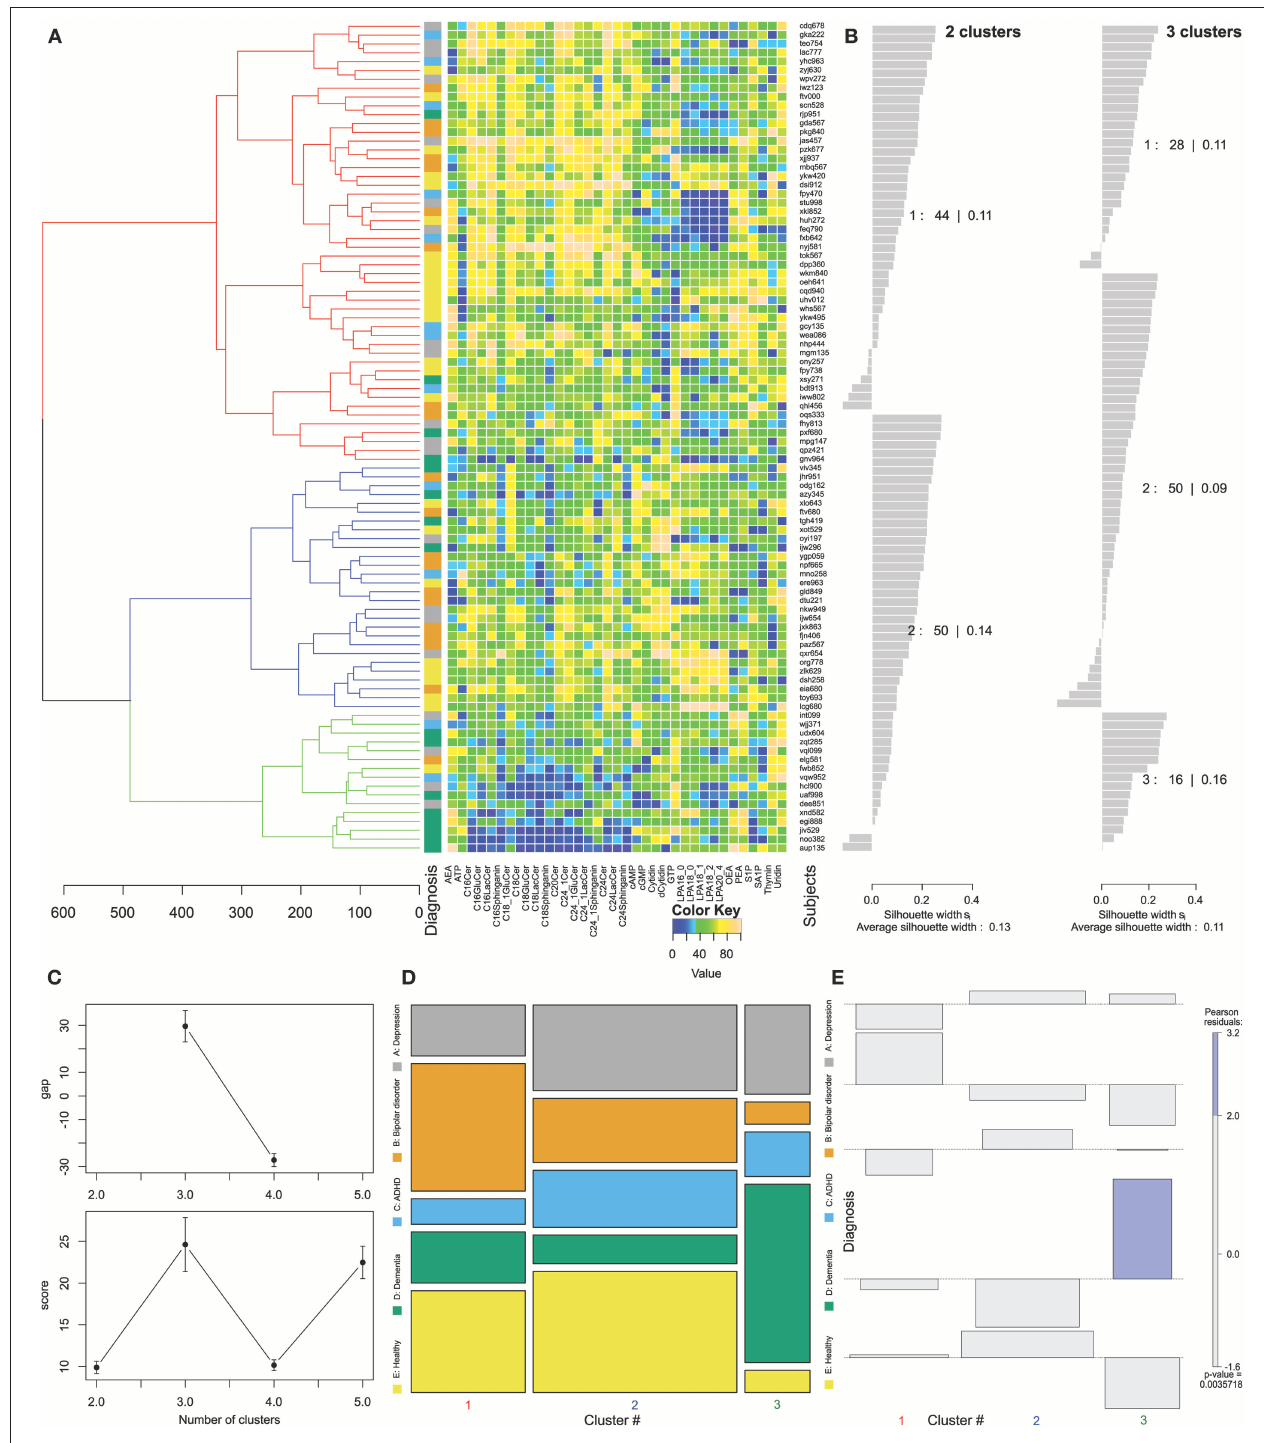
FIGURE 2 | Data structure found obtained by means of Ward clustering (24) of the data space of d = 35 plasma lipid mediator concentrations acquired in n = 94 subjects. (A) Cluster dendrogram showing three clusters, and matrix plot of the transformed and age corrected data rescaled to a range of [0,…,100] shown in the adjacent matrix plot displaying the transformed concentrations of d = 35 lipid mediators (columns) acquired from n = 94 subjects (rows) with color coding for the scaled data. (B) Silhouette plots (60) for 2 or 3 clusters, which indicate how near each sample is to its own relative to the neighboring clusters. Positive values indicate that the sample is away from the neighboring clusters while negative values indicate that those samples might have been assigned to the wrong cluster because they